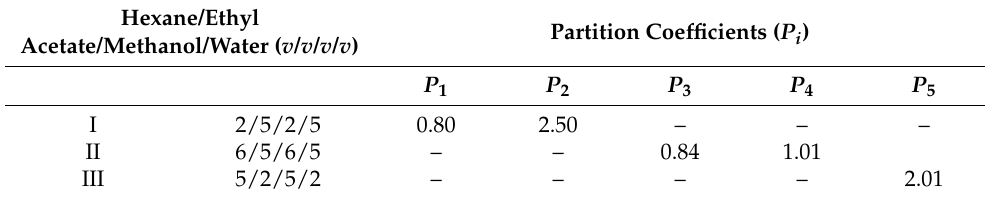
Table 1. Partition coefficient values of the target coumarins from Seseli devenyense methanolic fruit extract. Hexane/Ethyl